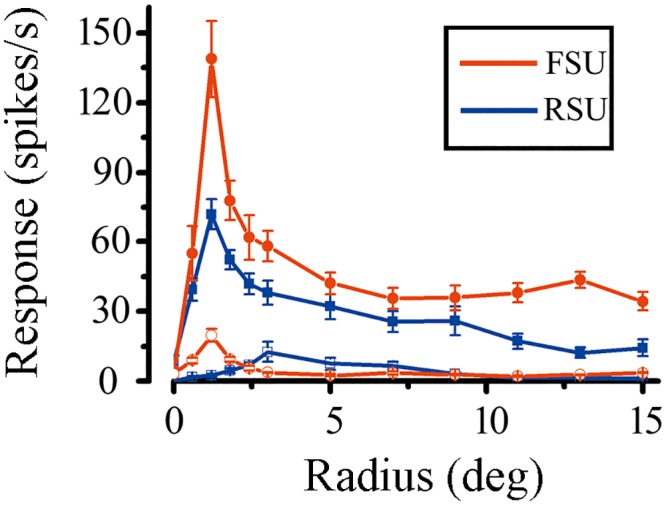
The spatial summation curves of two V1 neurons at high and low contrast.The red and blue line represents a FSU and a RSU for each. The curve with solid symbols represents the spatial summation curve measured at high contrast and the curve with open symbols at low contrast.